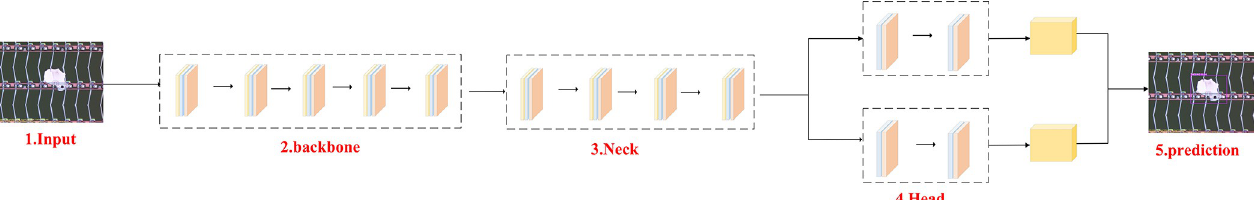
Fig 2. A kind of supervised target detector applied to the detection of surface defects in electronic panels. It includes Backbone, Neck, and Double T-head with features extracted by T-deformable convolution module, which will be described in detail in Chapter 3.